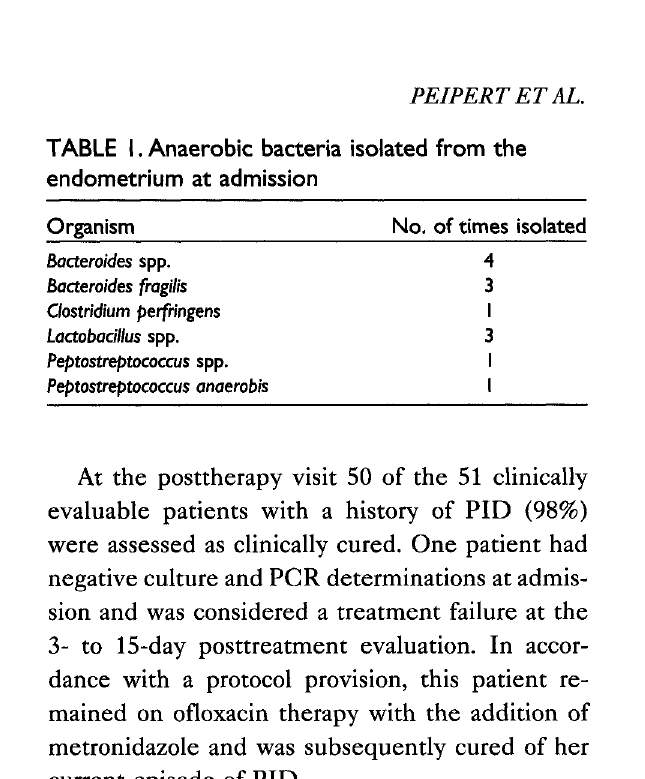
TABLE I. Anaerobic bacteria isolated from the endometrium at